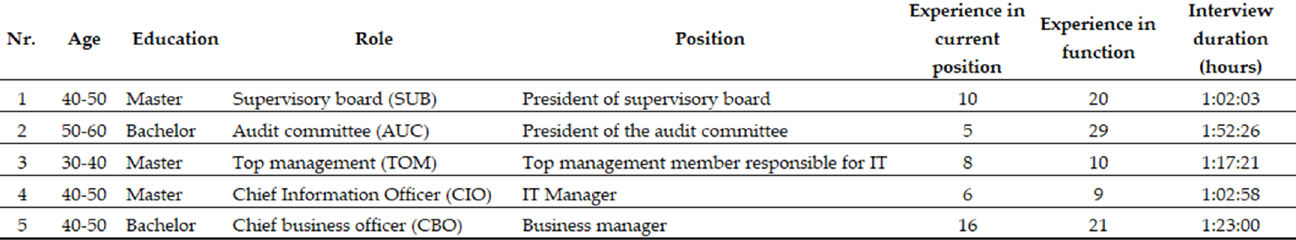
Figure 1. Personal information of interviewees.